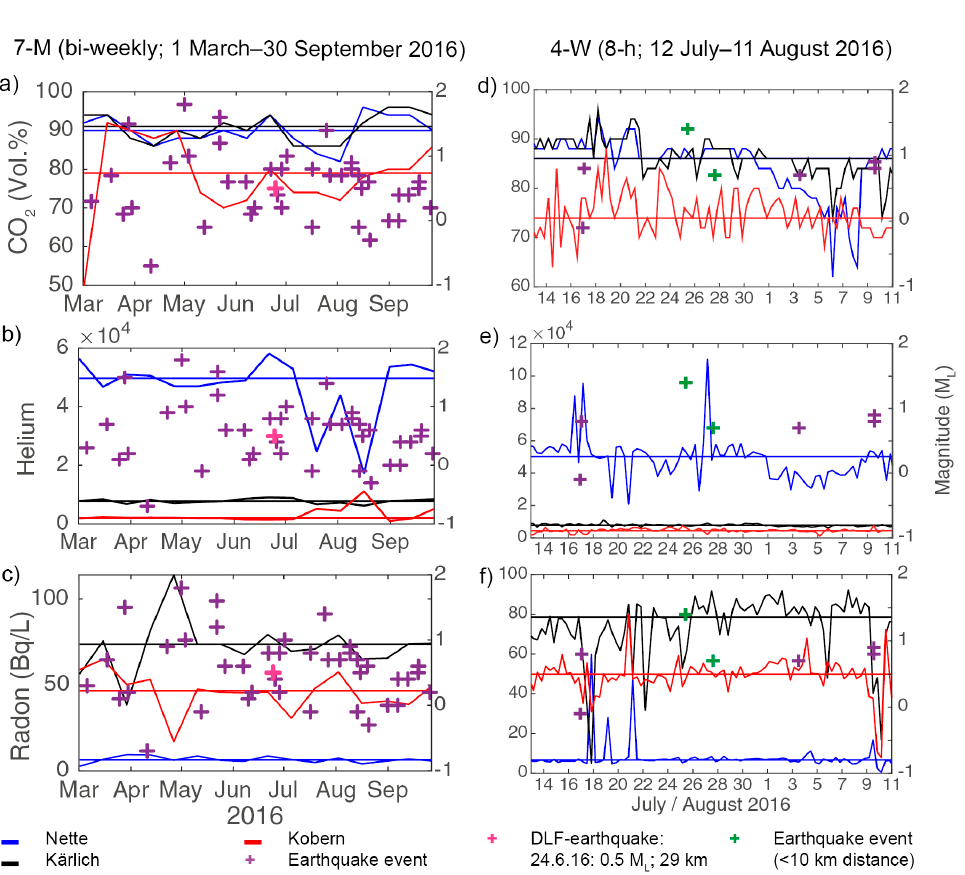
Figure A3. Gas concentrations (raw data) during the bi-weekly ( a – c ) and 8-hourly ( d – f ) survey in the mineral springs and earthquake events (M L ) indicated by purple crosses. The DLF-earthquake on 24 June 2016 in Niedermendig is marked in magenta ( a – c ); earthquakes with a distance < 12 km during the 4-W sampling are marked in green ( d – f ). Median values are indicated by the horizontal lines colored according to the spring colors.